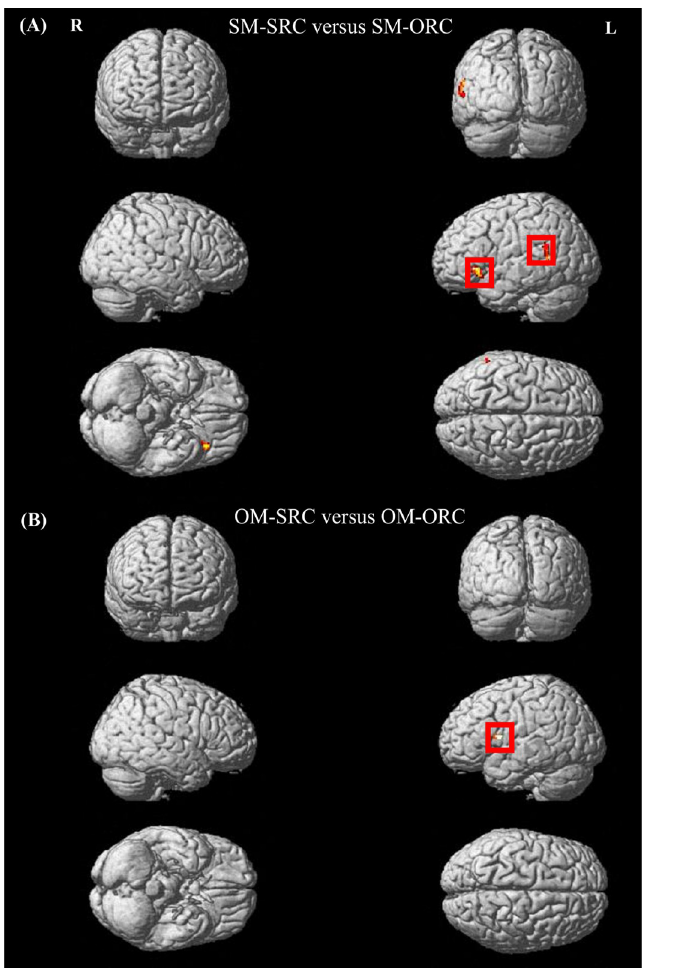
Fig 4. Volume rendering of the contrast between the SRCs and the ORCs in different modifying positions. The results indicate that (A) greater activation in the LIFG and the LSTG is significantly involved in the processing of the SM-SRC sentences compared to the SM-ORC sentences; (B) enhanced activation in the LIFG is significantly evoked by the OM-SRC sentences rather than the OM-ORC